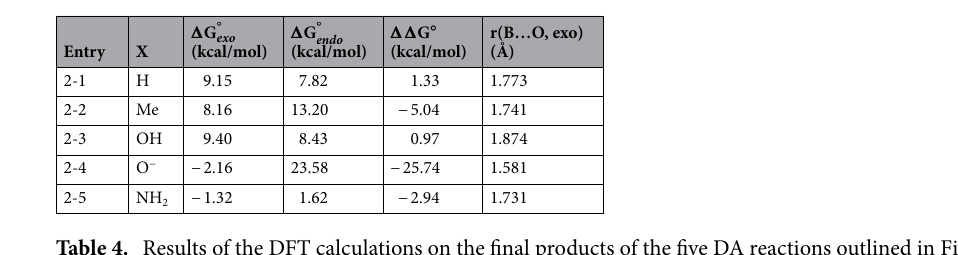
Table 4. Results of the DFT calculations on the final products of the five DA reactions outlined in Fig. 4.